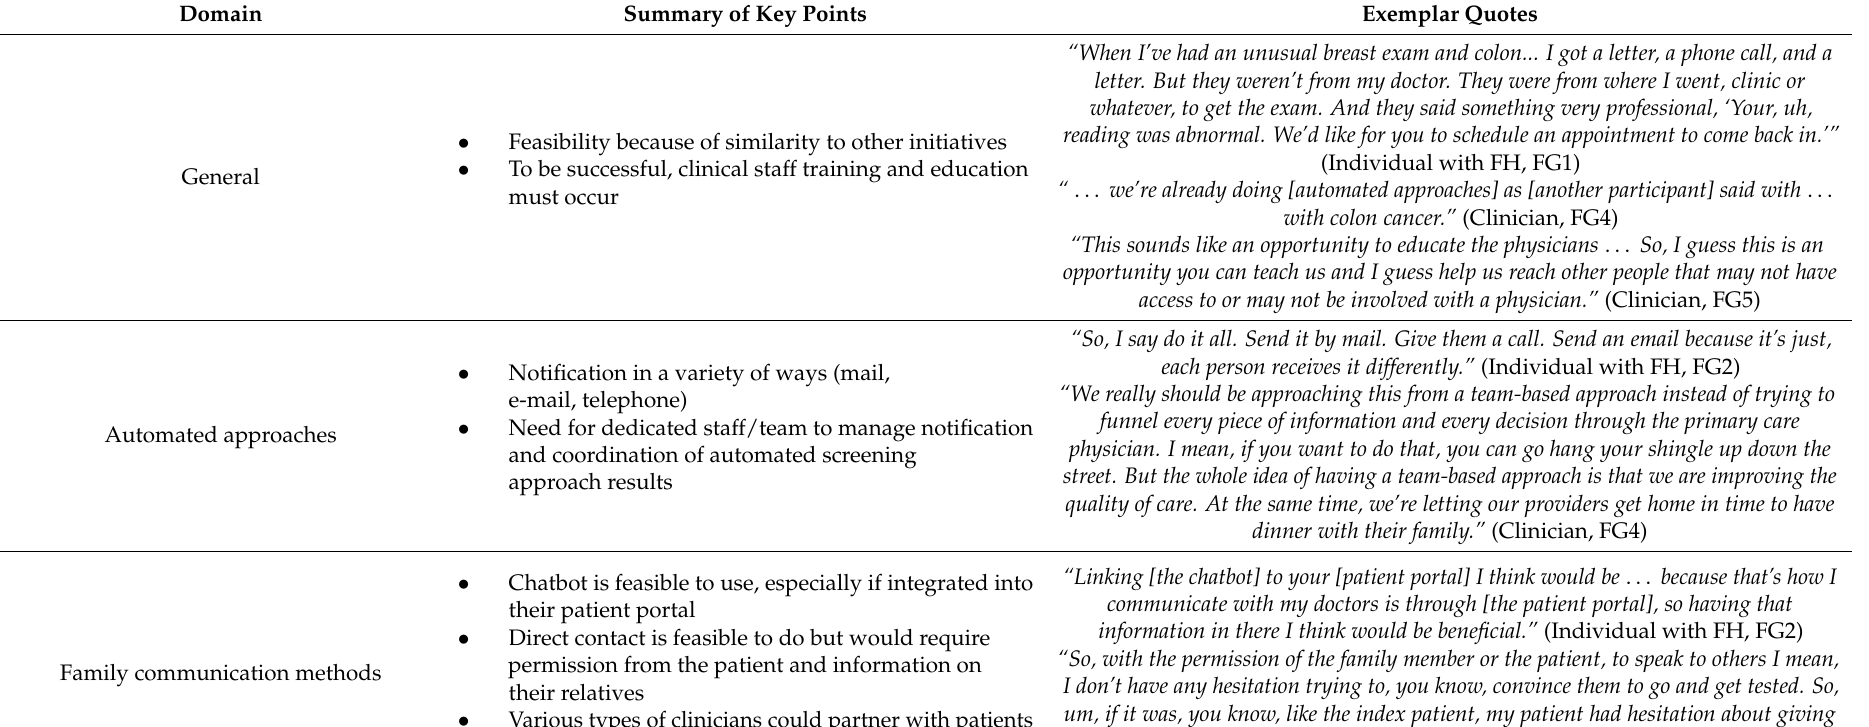
Table 5. Key points with exemplar quotes related to general feasibility and specific feasibility related to automated screening approaches and family communication methods.